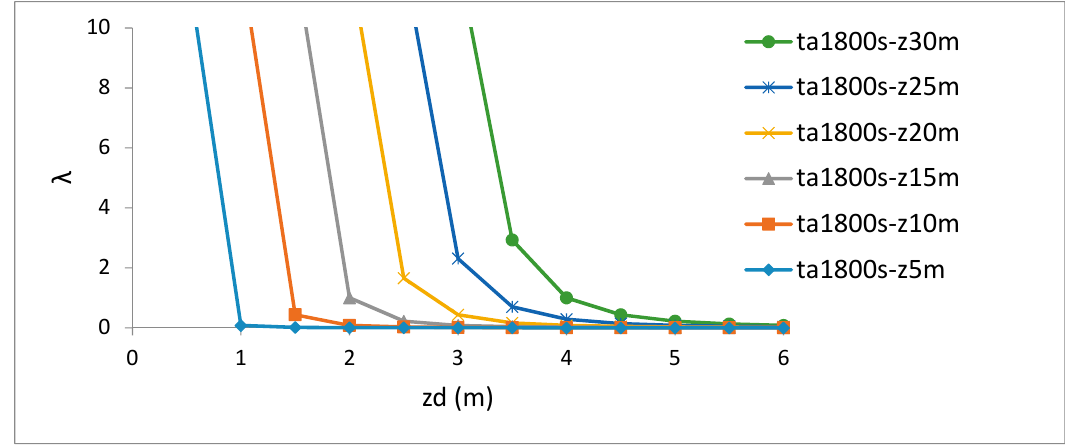
Figure 11. Relationship among nudging parameters.